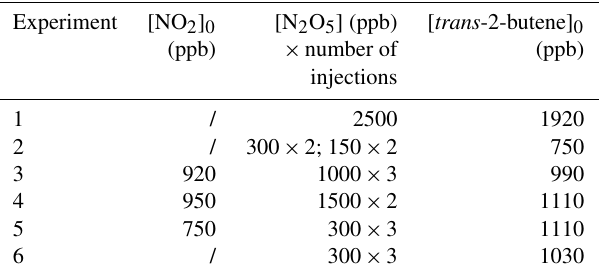
Table 2. Injected mixing ratios for the kinetic study of the reaction trans -2-butene + NO 3